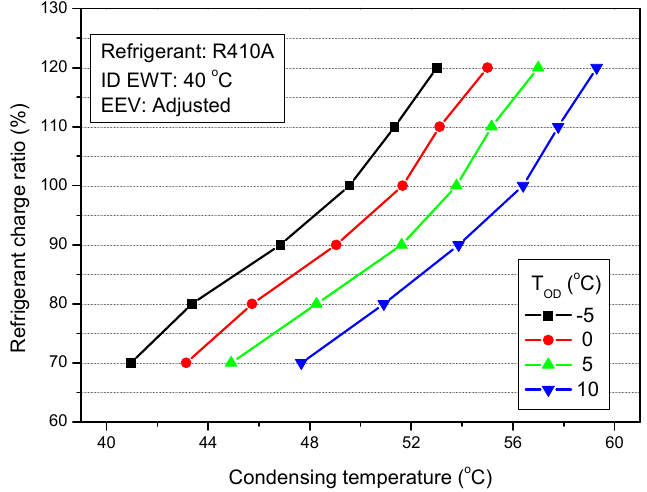
Energies 2018 , 11 , x FOR PEER REVIEW Figure 27. Relationship between refrigerant charge ratio and condensing temperature in heating mode.